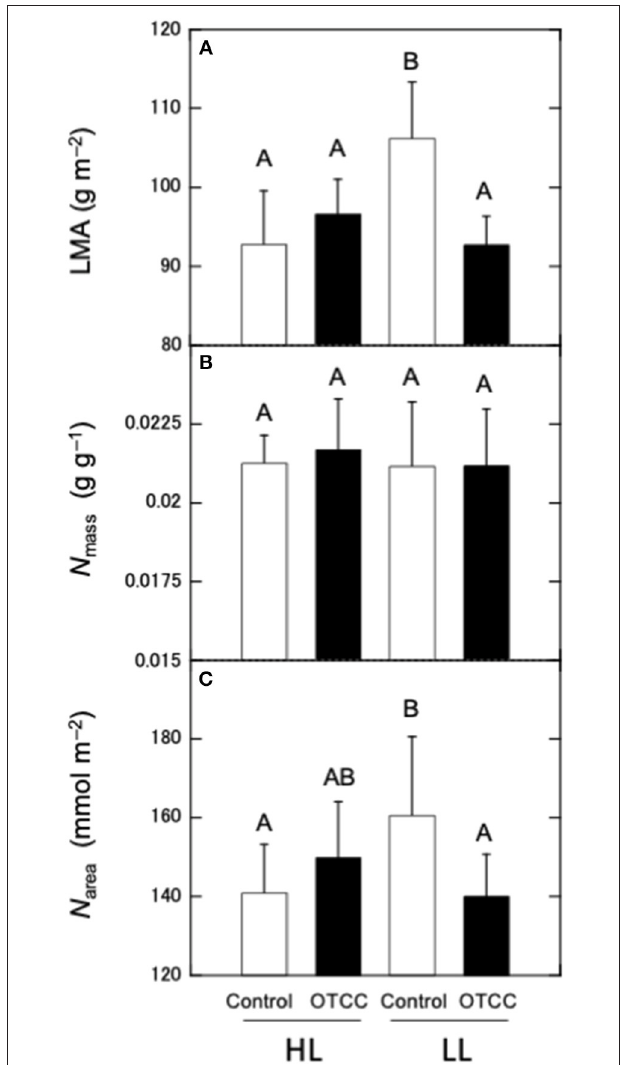
TABLE 1 | Monthly average of daytime leaf temperature ( ◦ C; photosynthetic photon flux density > 0 µ mol m − 2 s − 1 ) in control and open-top canopy chamber (OTCC) branches in high (HL) and low (LL) latitude site in 2012. HL FIGURE 1 | Effects of warming on (A) leaf mass per area (LMA), (B) nitrogen concentration per mass ( N mass ), and (C) nitrogen concentration per area ( N area ) in canopy leaves of Quercus serrata at high (HL) and low (LL) latitudinal sites. Measurements were made in August 2012. Leaves were exposed to either naturally changing temperature conditions (control; open boxes) or experimental warming with OTCC (open-top canopy chamber; closed boxes) (simple means ± standard deviation, n = 12). Different letters indicates significant differences at P < 0.05 by Tukey’s test, where individual trees are incorporated as a random